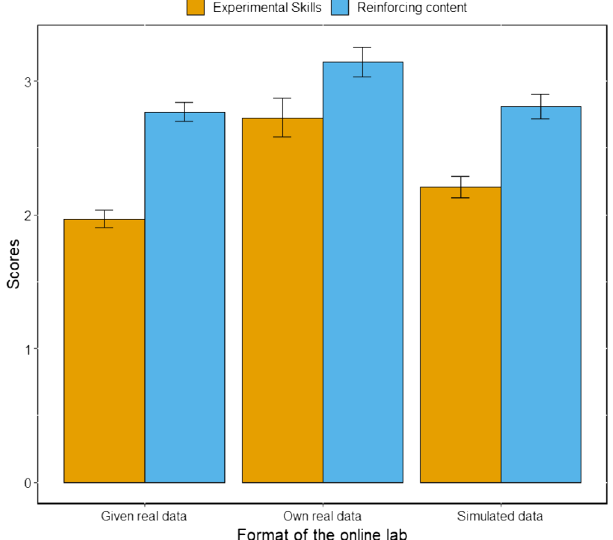
FIG. 4. Evaluation of the physics lab with respect to different types of